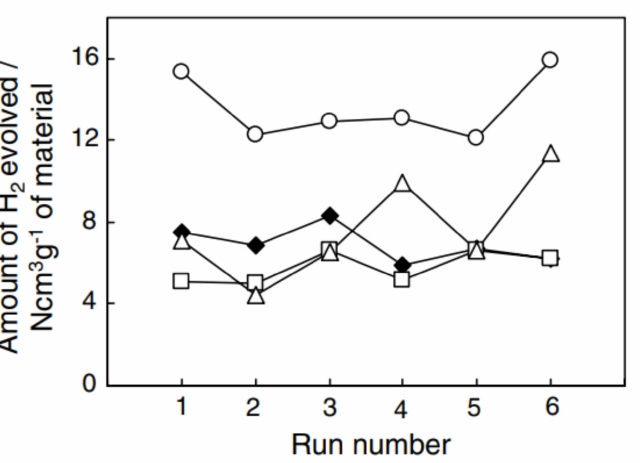
Figure 13. Amount of hydrogen generated as a function of the cycle number. The reduction reaction took place at 1400 ◦ C. The open circles represent NiFe 2 O 4 /m-ZrO 2 , the open triangles Ni 0.65 Fe 2.35 O 4 /m-ZrO 2 , the diamonds Fe 3 O 4 /m-ZrO 2 and the open squares Ni 0.35 Fe 2.65 O 4 /m-ZrO 2 . Monoclinic zirconium (IV) oxide is denoted by m-ZrO 2 in this figure and the ferrite loading on the support was 20 wt%. Reprinted from